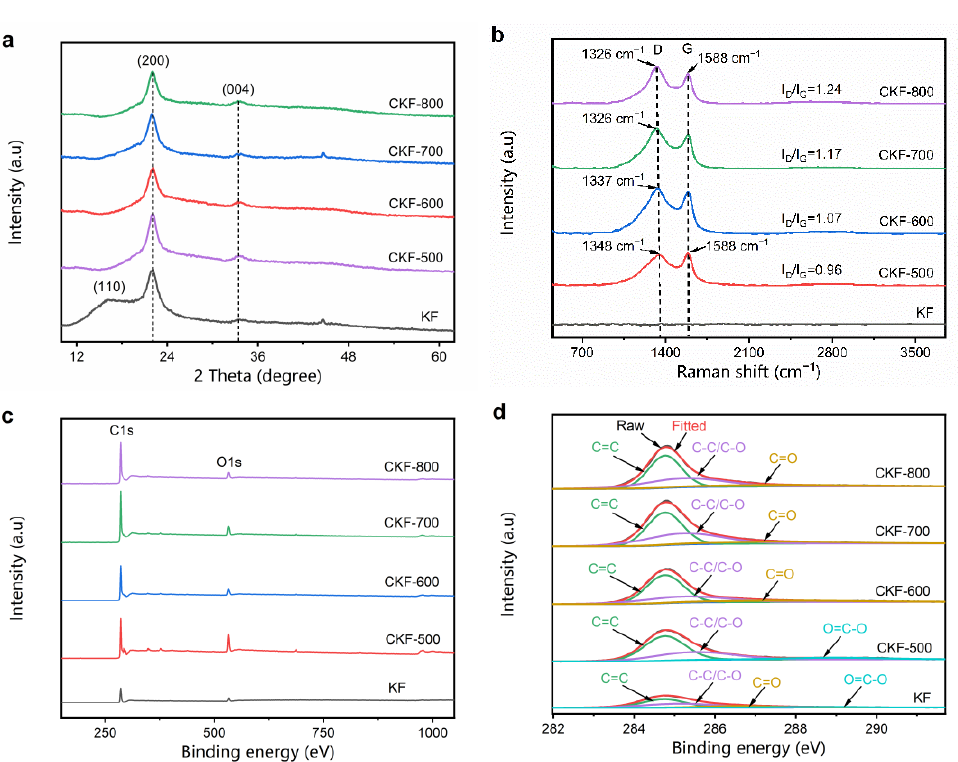
Figure 2. ( a ) XRD patterns, ( b ) Raman spectra, ( c ) XPS curves, and ( d ) high resolution C1s